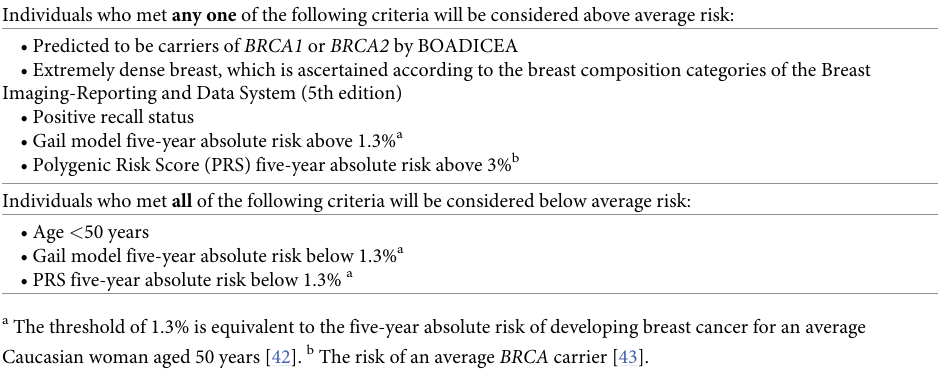
Table 2. Breast cancer risk reclassification criteria.